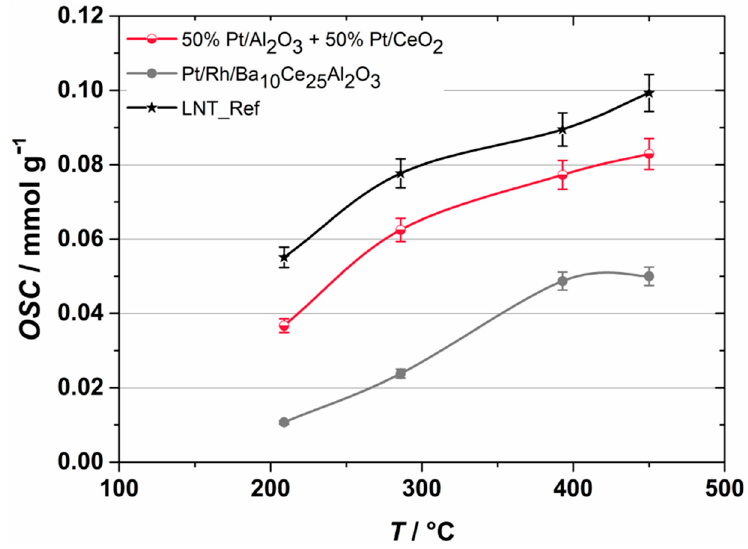
Figure 5. Temperature dependent oxygen storage capacities the reference LNT and the different Ceria containing catalysts.